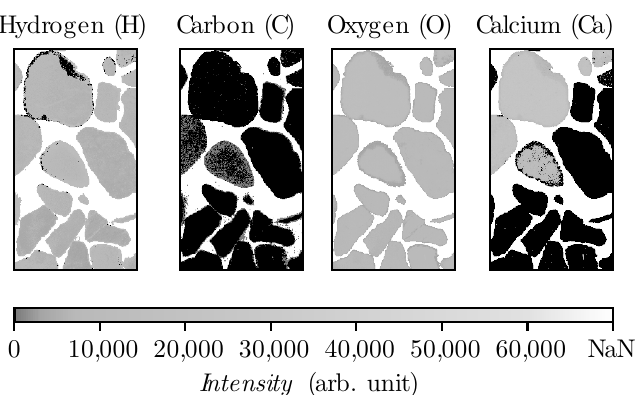
Figure 6. Masking oxygen heatmap regarding the empty points within the aggregates after epoxy removal from sample type (1) in spectral range 525–940